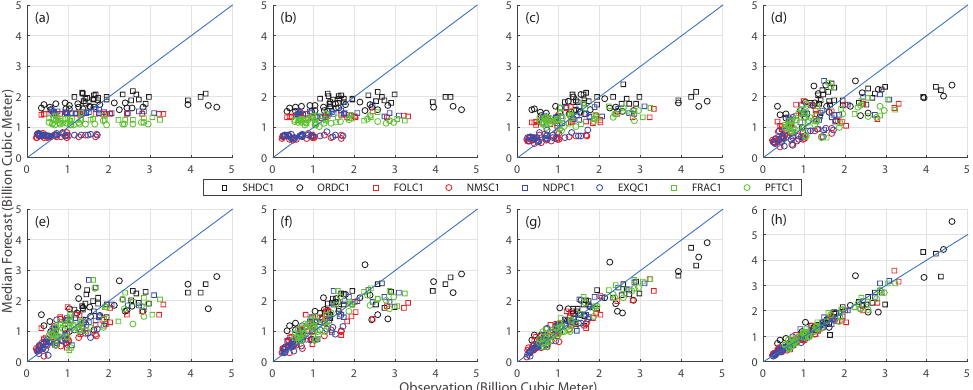
Figure 5. Scatter plot of median forecasts versus observation on the monthly scale: ( a ) 1 October; ( b ) 1 November; ( c ) 1 December; ( d ) 1 January; ( e ) 1 February; ( f ) 1 March; ( g ) 1 April and ( h ) 1